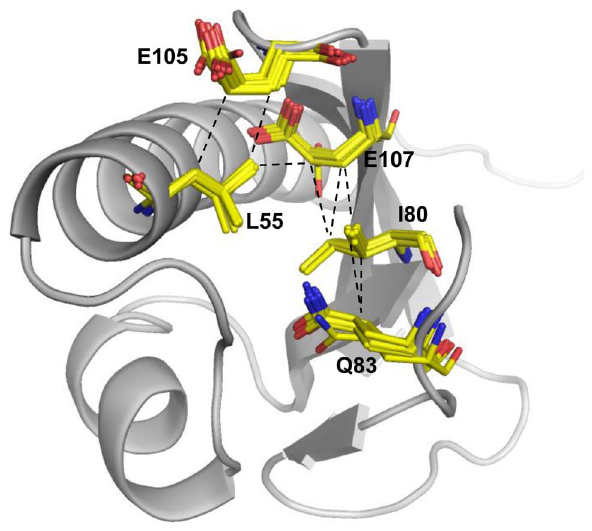
Figure 4. Solution structure of the ESD (E83Q). The Q83, E105, and E107 residues interact with the L55 and I80 residues in the ensemble of 10 lowest-energy structures, which are superimposed with yellow sticks. The dashed line indicates that distances between two carbons are less than 4 angstroms in all of the 10 lowest structures.